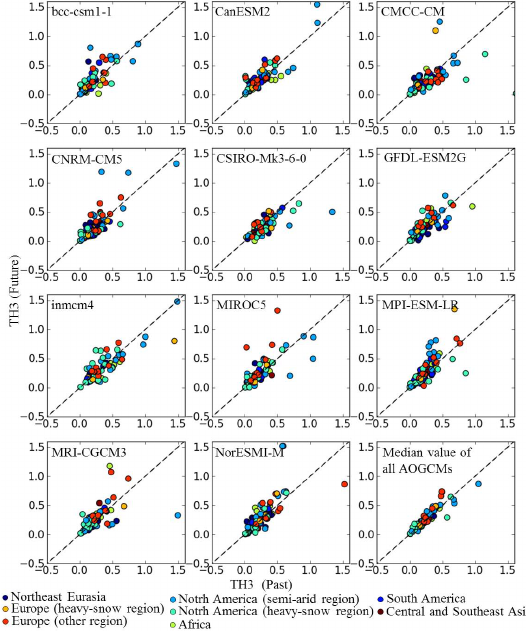
Fig. A1. Comparisons of mean river discharge (log-MAD) between past and future in each of the 11 coupled atmosphere–ocean general circulation models.